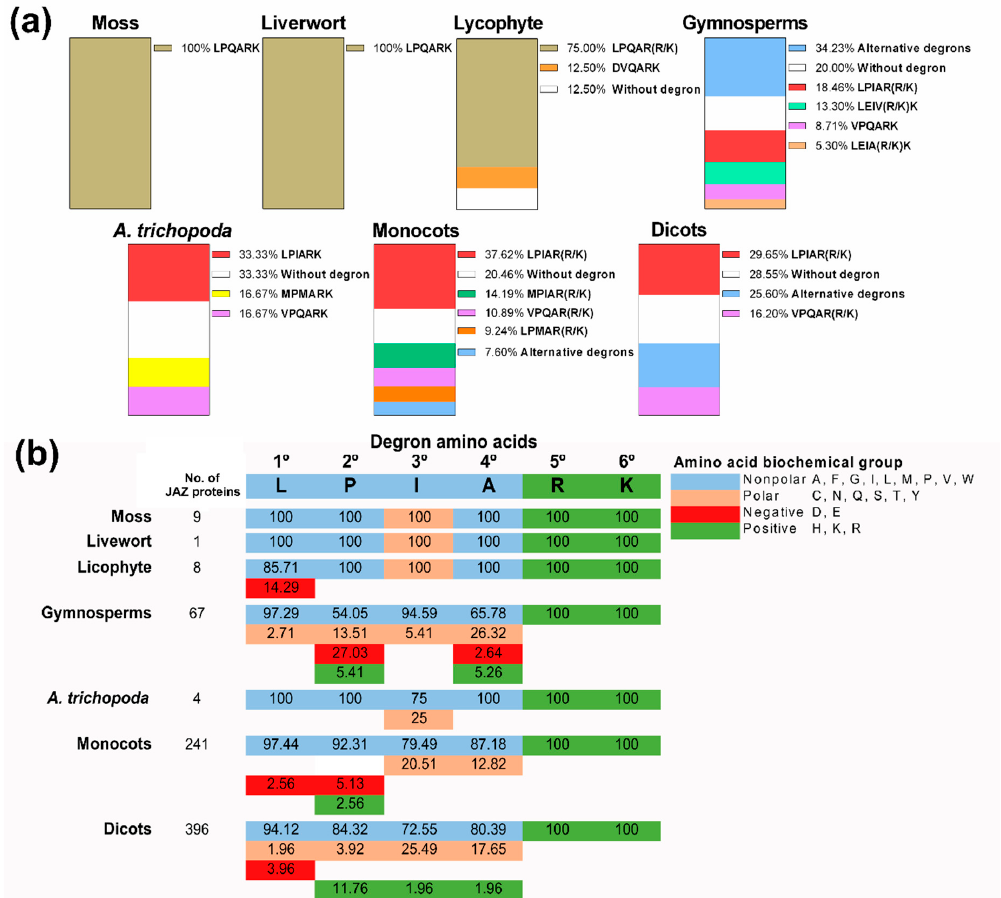
Figure 5. Analysis of degron sequences in different lineages of the plant kingdom. ( a ) Percentage (%) of specific degron sequences in each plant lineage. ( b ) Percentage (%) of different amino acid biochemical groups in each position of the degron sequence compared with the canonical degron LPIARK. The percentage (%) of specific degrons was obtained from 9, 1, 8, 195, 6, 303 and 543 sequences for moss, livewort, lycophyte, gymnosperms, Amborella trichopoda , monocots and dicots, respectively. The percentage (%) of different amino acid biochemical groups in each position of the degron sequence was obtained from 1, 1, 3, 37, 3, 39 and 51 different degron sequences for moss, livewort, lycophyte, gymnosperms, A. trichopoda , monocots and dicots, respectively.